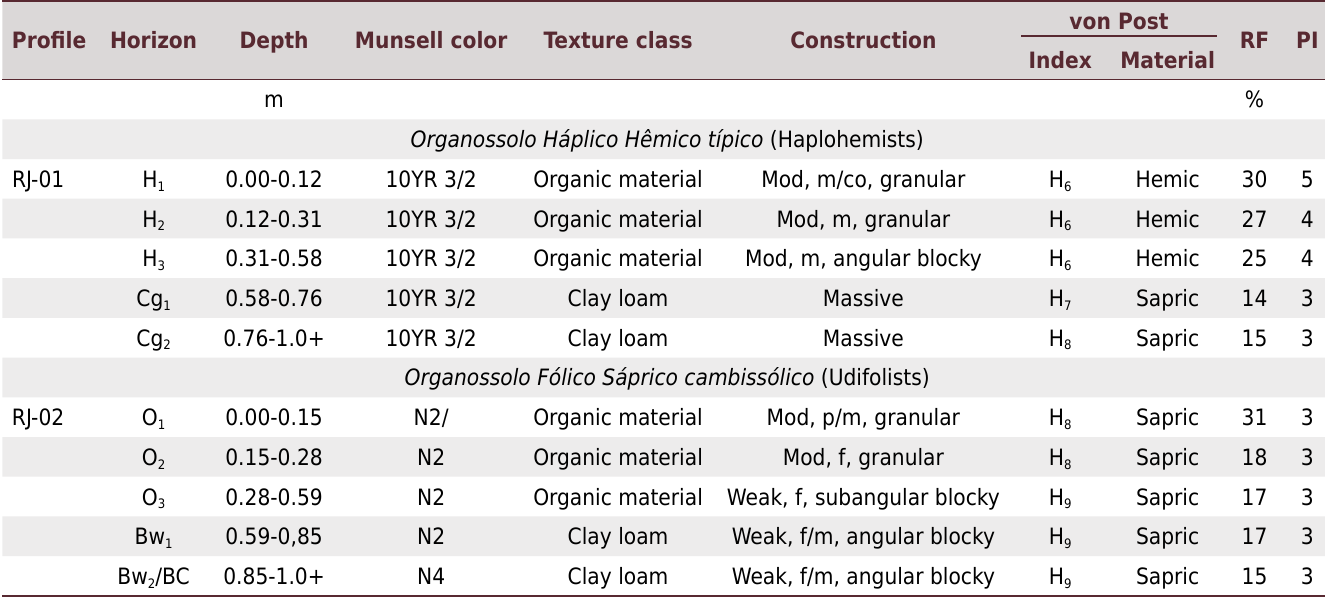
Table 1. Description of morphological properties and degree of decomposition of organic matter indicators in Organossolos in the upper montane environment of Itatiaia National Park, Rio de Janeiro, Brazil Profile